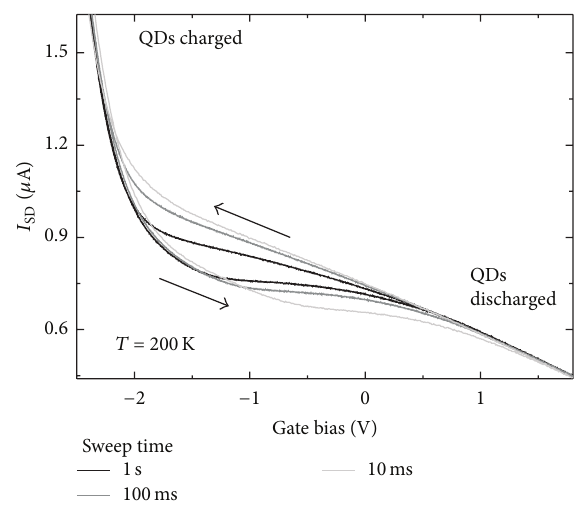
Figure 3: Source-drain current measurements for gate voltage sweeps with different sweep times at a temperature of 200 K. The curves show a clear hysteresis opening due to the memory effect of the